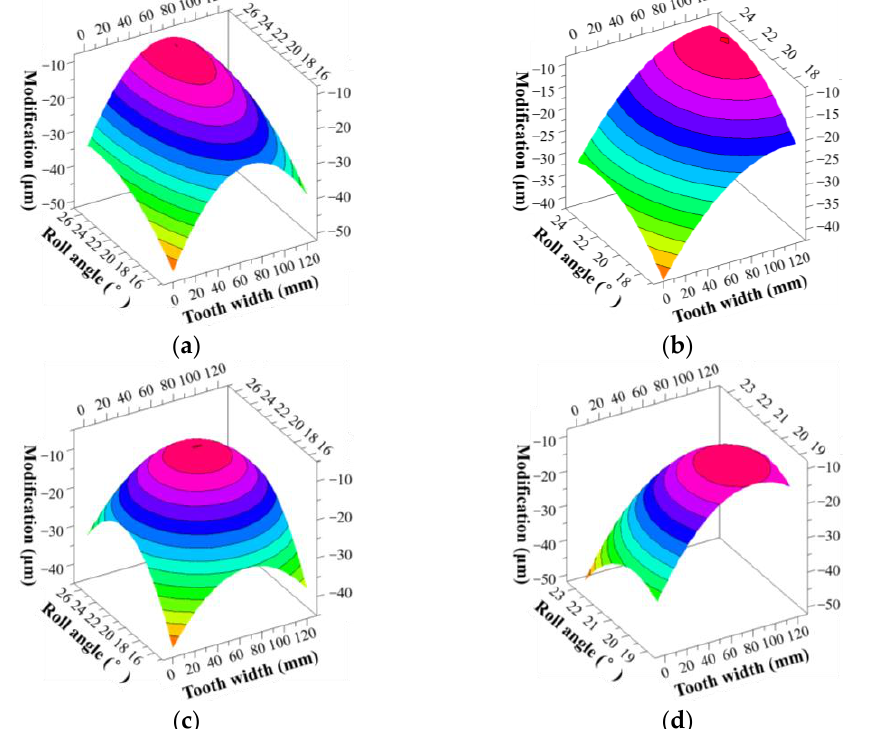
Figure 10. Contour map of tooth surface modification: ( a ) planet gear tooth surface meshed with sun gear; ( b ) working tooth surface of sun gear; ( c ) planet gear tooth surface meshing with ring gear; ( d ) working tooth surface of ring gear.